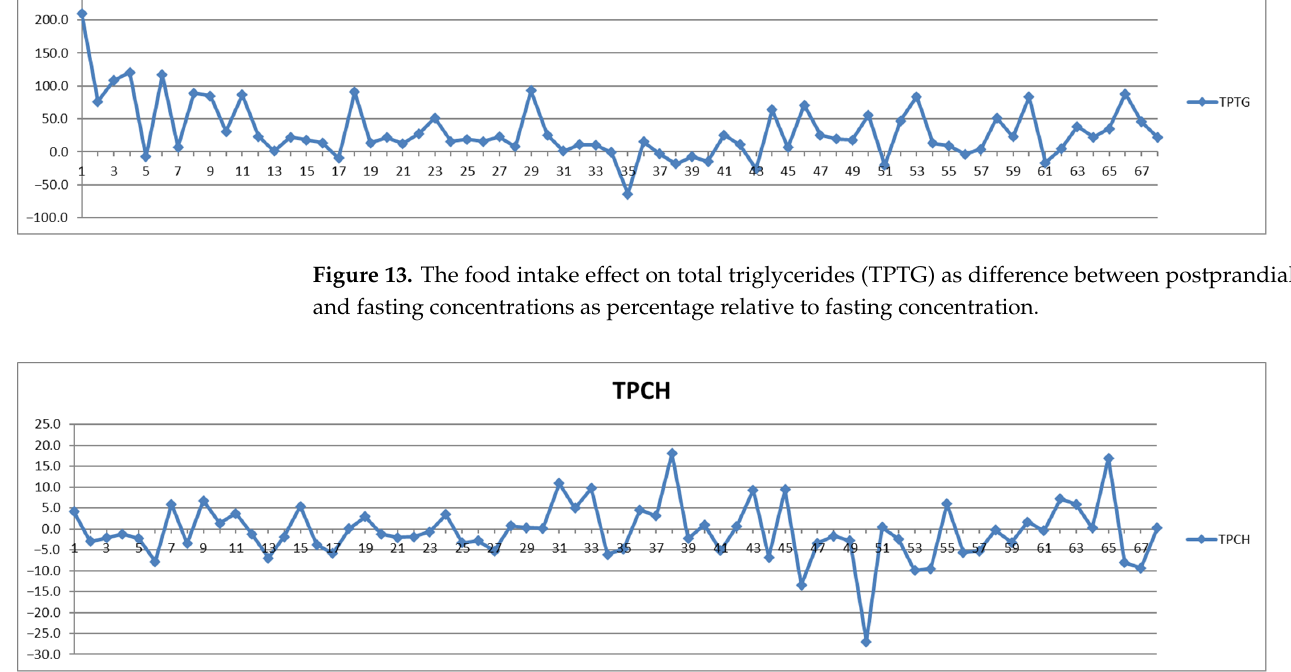
Figure 14. The food intake effect on total cholesterol (TPCH) as difference between postprandial and fasting concentrations as percentage relative to fasting concentration.